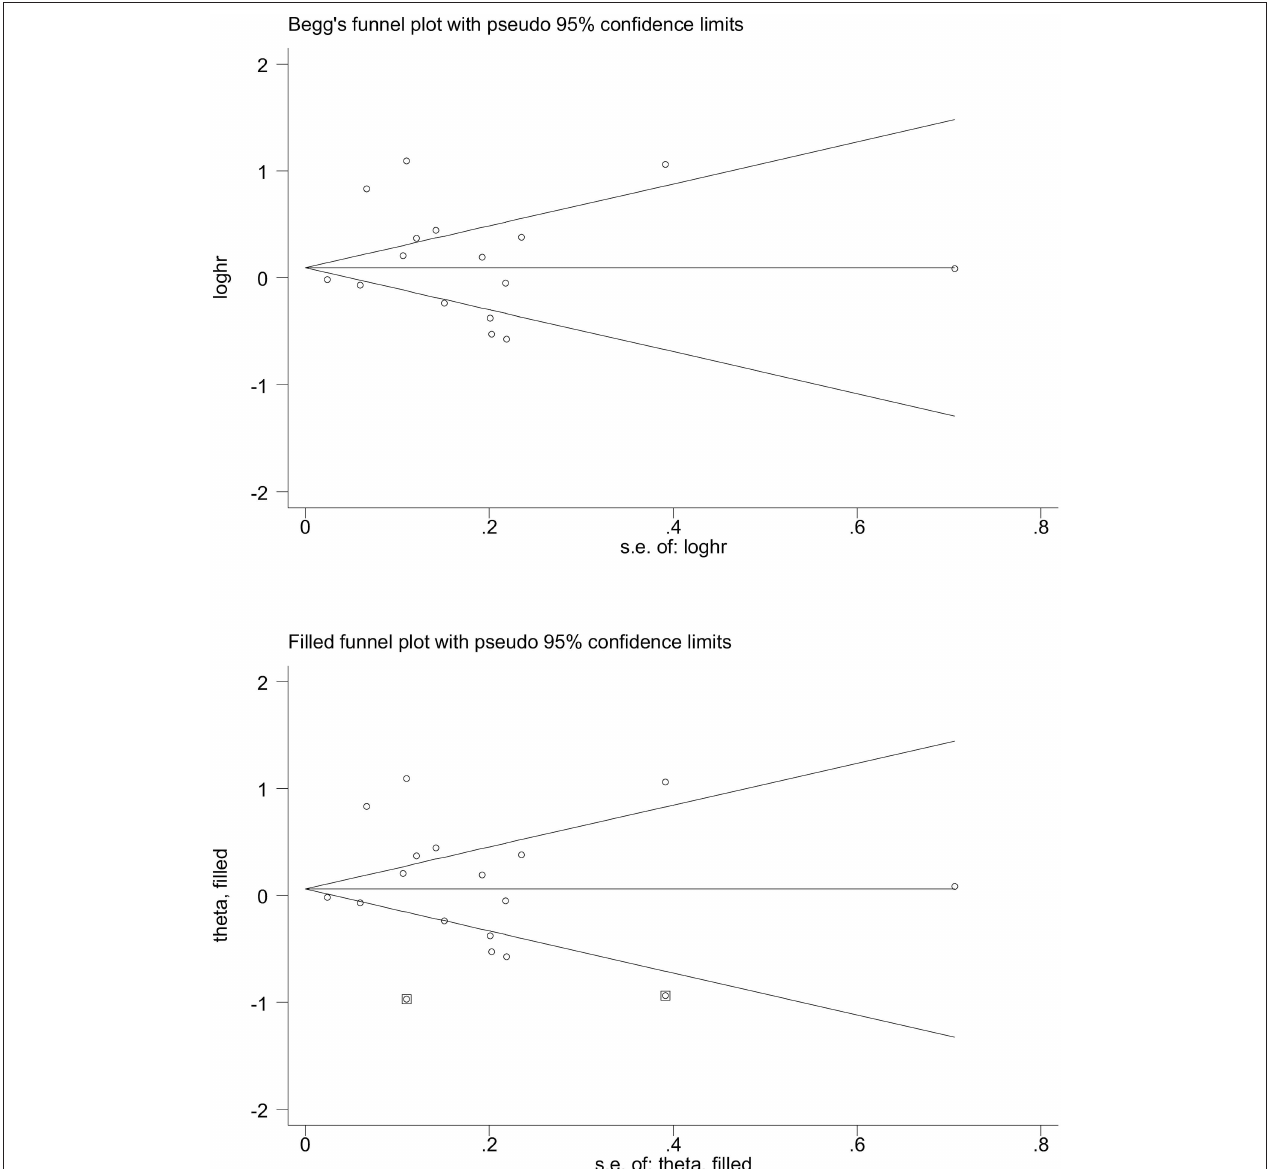
FIGURE 2 | Begg’s (Upper) and filled (Lower) funnel plots for the prediction of metabolic syndrome for the survival of digestive tract cancer. loghr, logarithm of hazard ratio; s. e.: standard error.